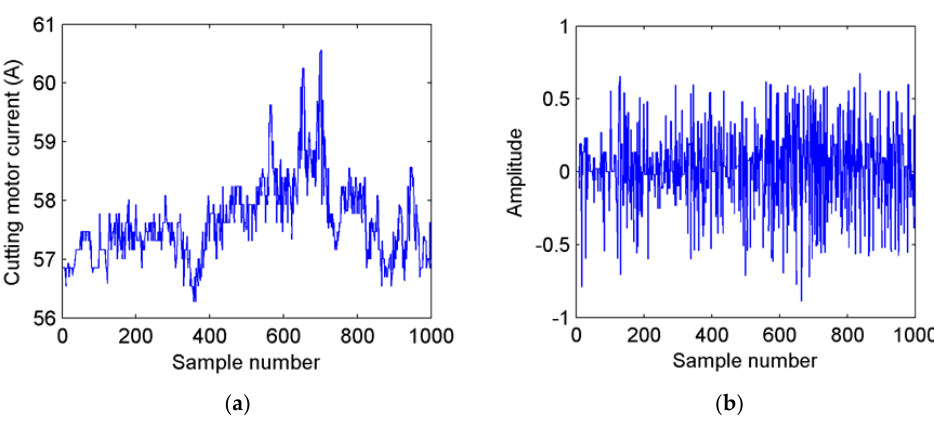
Figure 3. System noise analysis of cutting motor current: ( a ) the original signal of cutting motor current; and ( b ) the system noise information.